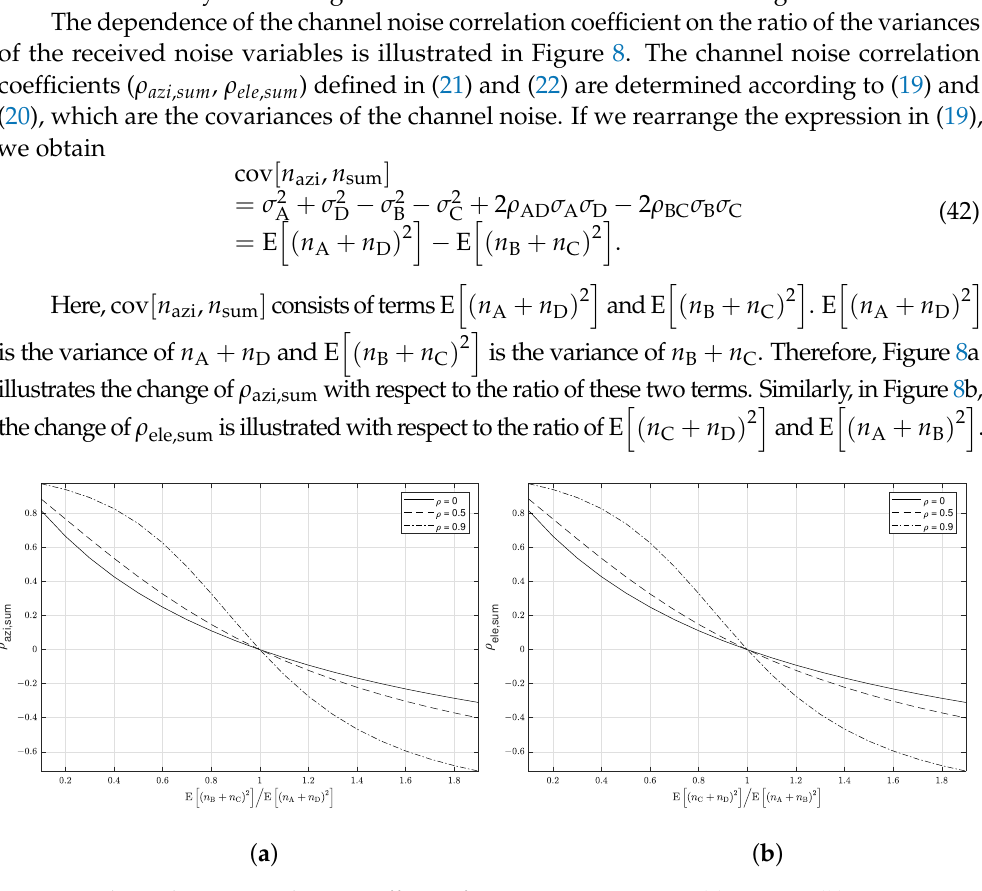
Figure 8. Channel noise correlation coefficient for noise variance ratio. ( a ) ρ azi,sum . ( b ) ρ ele,sum